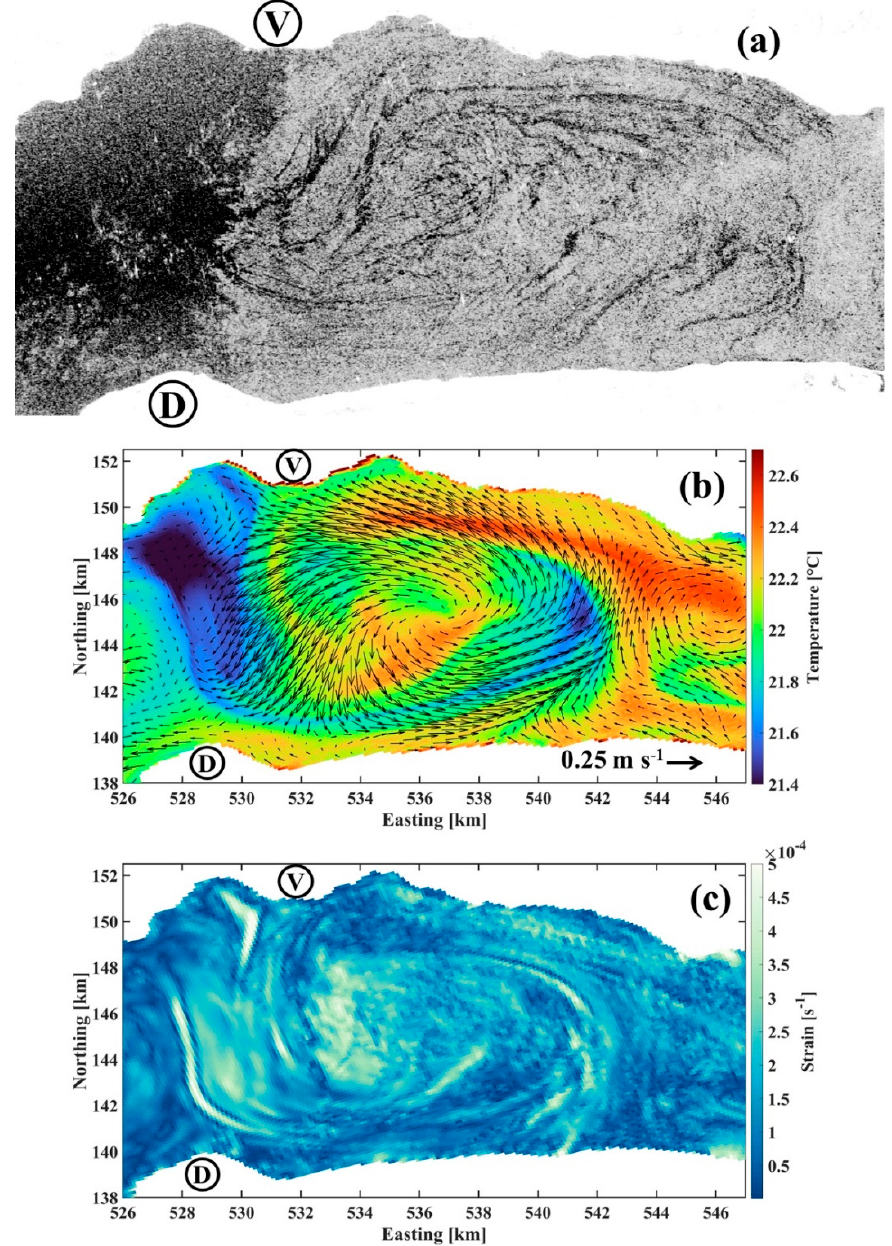
Figure 3. ( a ) Subset of a Sentinel-1B SAR-C image acquired on 21 July 2018 at 17:31 UTC, ( b ) simulated temperature (color) and current velocity and direction (arrows) at 0.3-m depth, and ( c ) the horizontal strain rate (0.3-m depth), given by 𝑆𝑡𝑟𝑎𝑖𝑛 = (cid:3493)(𝜕𝑢 𝜕𝑥⁄ − 𝜕𝑣 𝜕𝑦⁄ ) (cid:2870) + (𝜕𝑣 𝜕𝑥⁄ + 𝜕𝑢 𝜕𝑦⁄ ) (cid:2870) , from a high-resolution, 3D numerical simulation for 21 July 2018 at 18:00 UTC. In this expression, ( u , v ) are the ( x , y ) components of horizontal velocity field. Colorbars in ( b , c ) give the ranges of temperature and strain rate, respectively. V and D are reference points marked in Figure